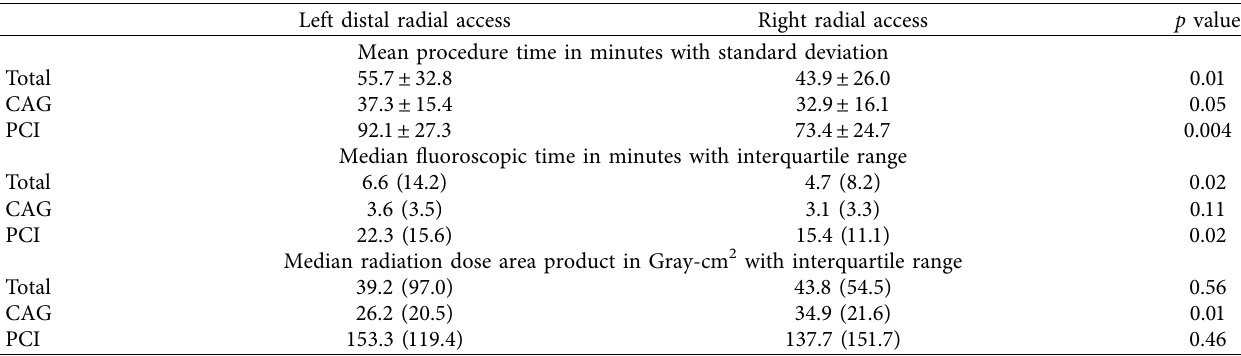
Table 4: Comparison between left distal radial and right radial access